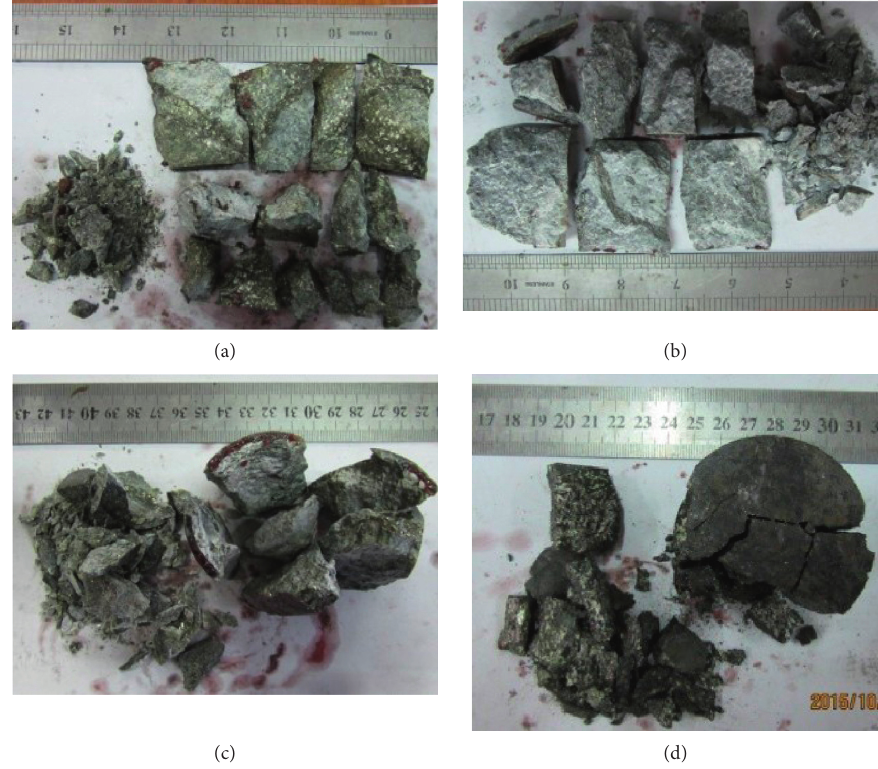
Figure 6: Failure mode of rock sample when preloading axial pressure is 85MPa. Unloading rates are (a) 0.5MPa/s, (b) 1.0MPa/s, (c) 1.5MPa/s, and (d) 2.0